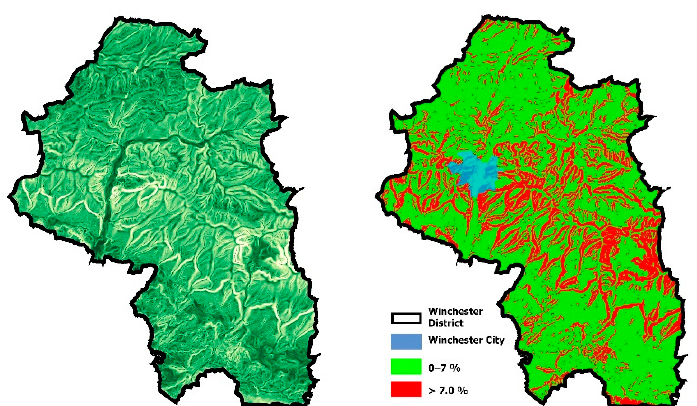
Figure 4. Topographical map of Winchester District’s ( left ) remaining road segments available for EV charging following the exclusion of all segments on a slope of more than 7% ( right ).